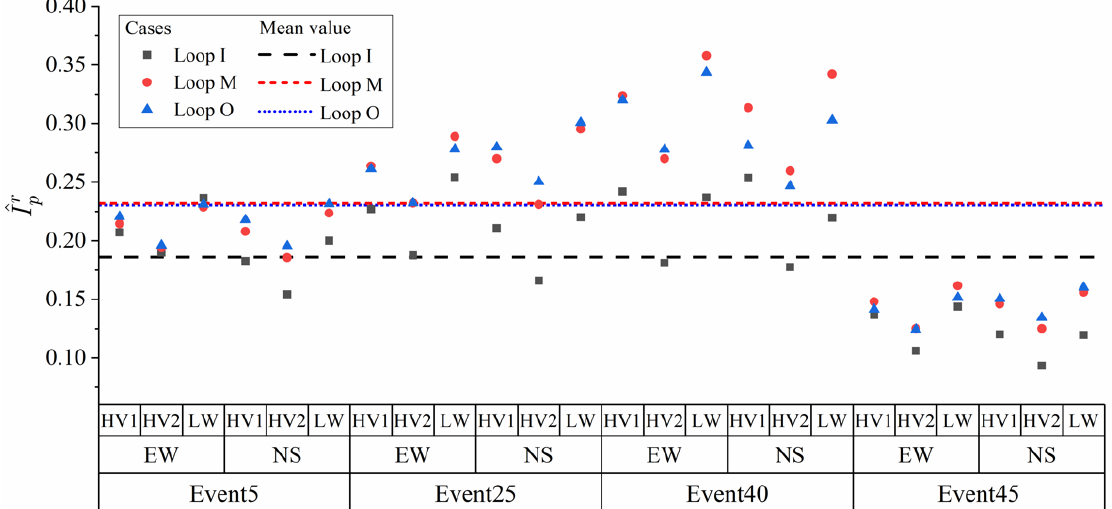
Figure 9. Simulated normalized power loop standard deviation with Gaussian model.